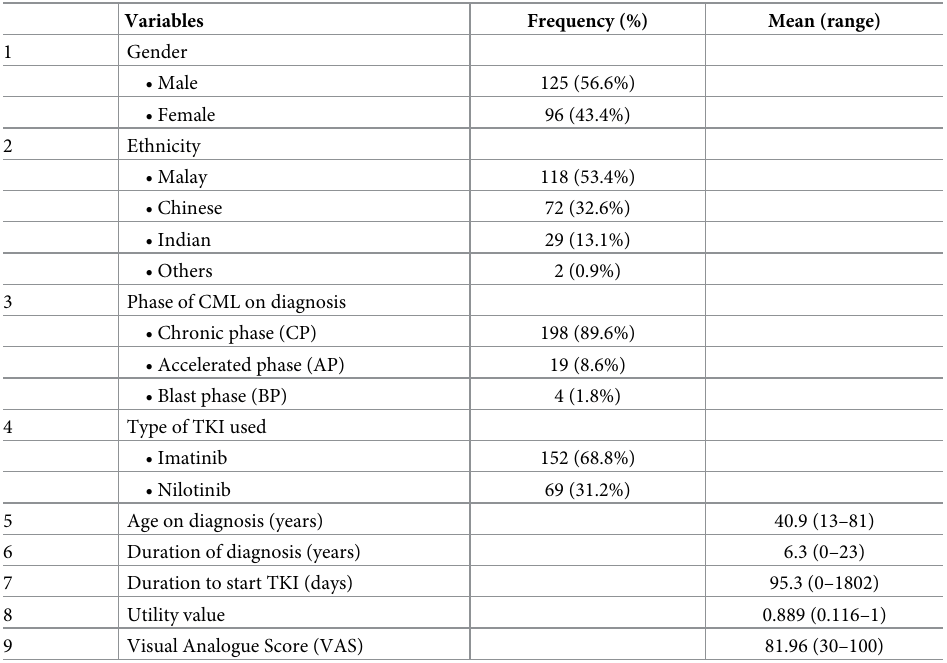
Table 1. Sociodemographic characteristics of CML study population.